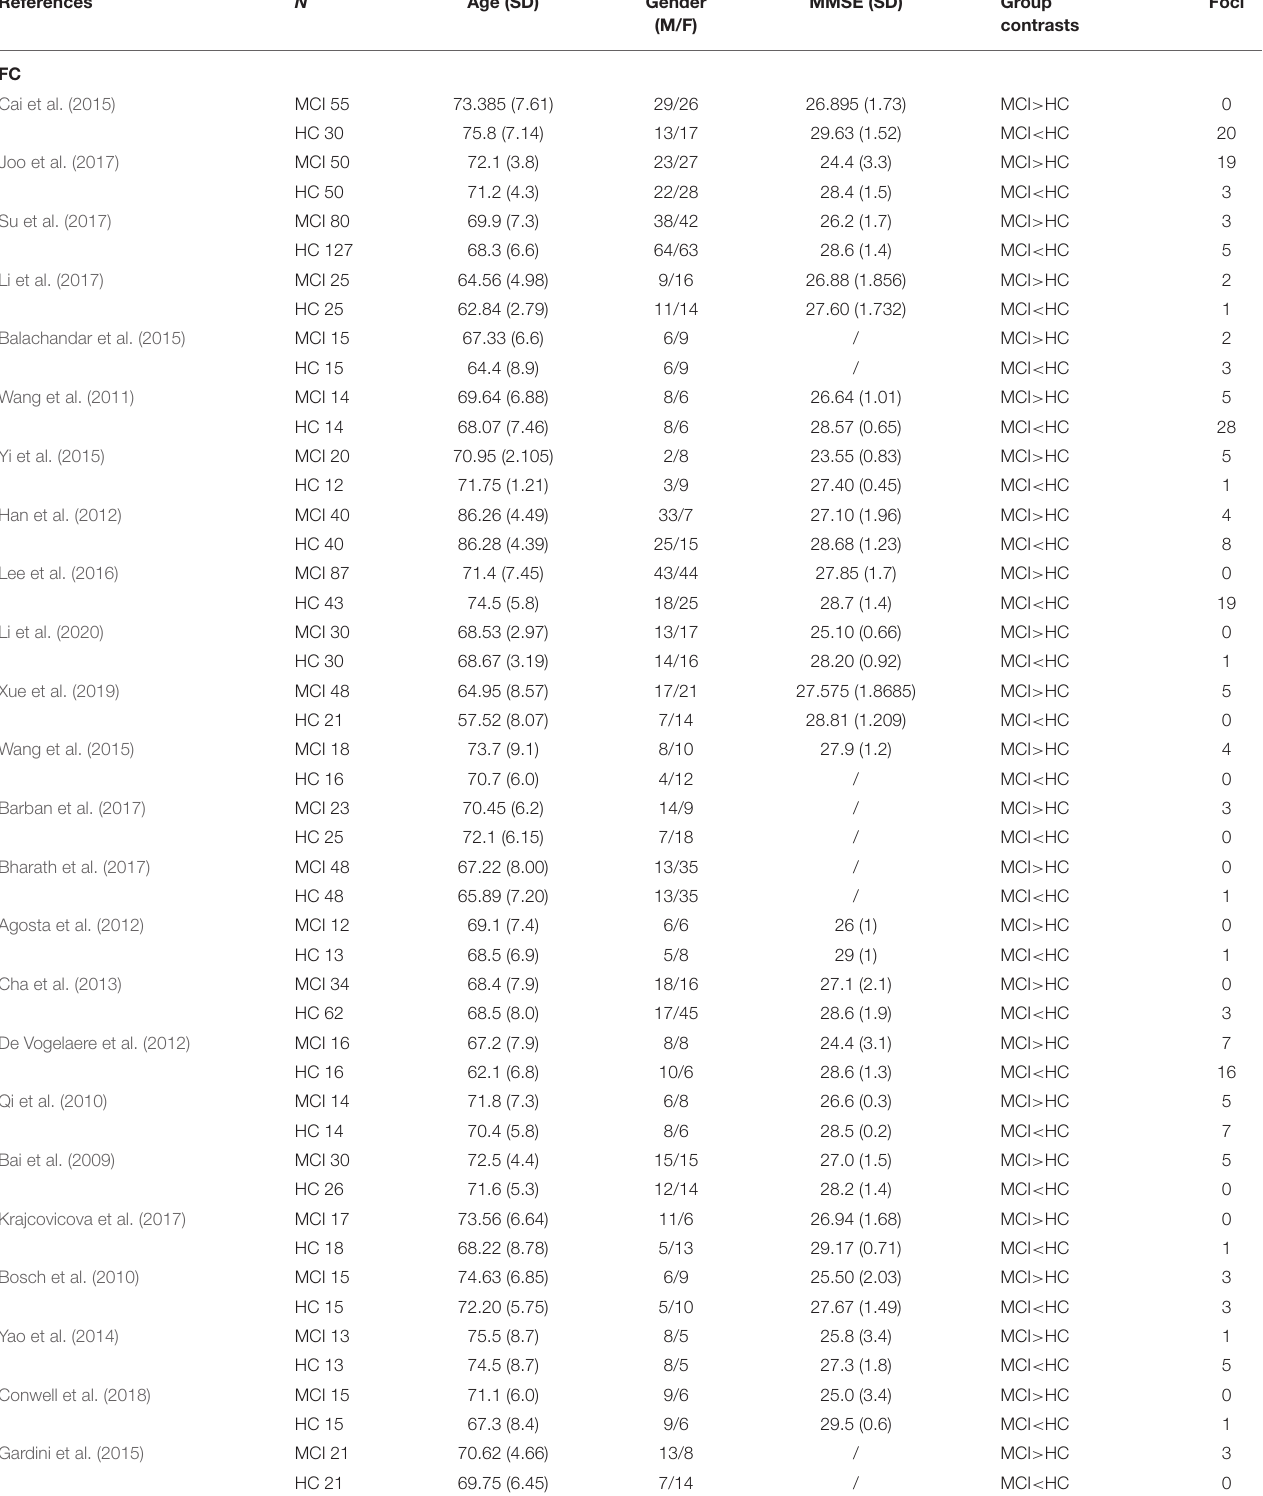
TABLE 1 | Demographic characteristics of the included